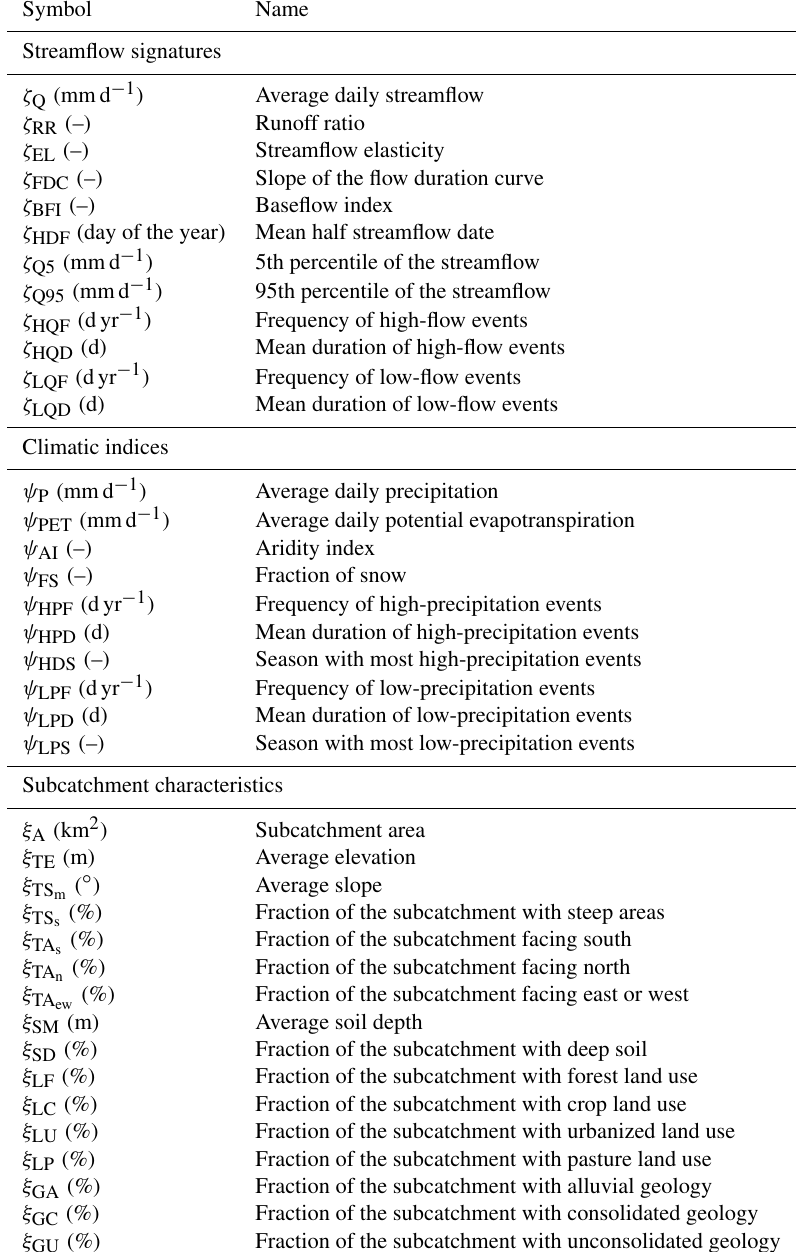
Table 2. List of streamflow signatures, climatic indices, and subcatchment characteristics considered in the study.